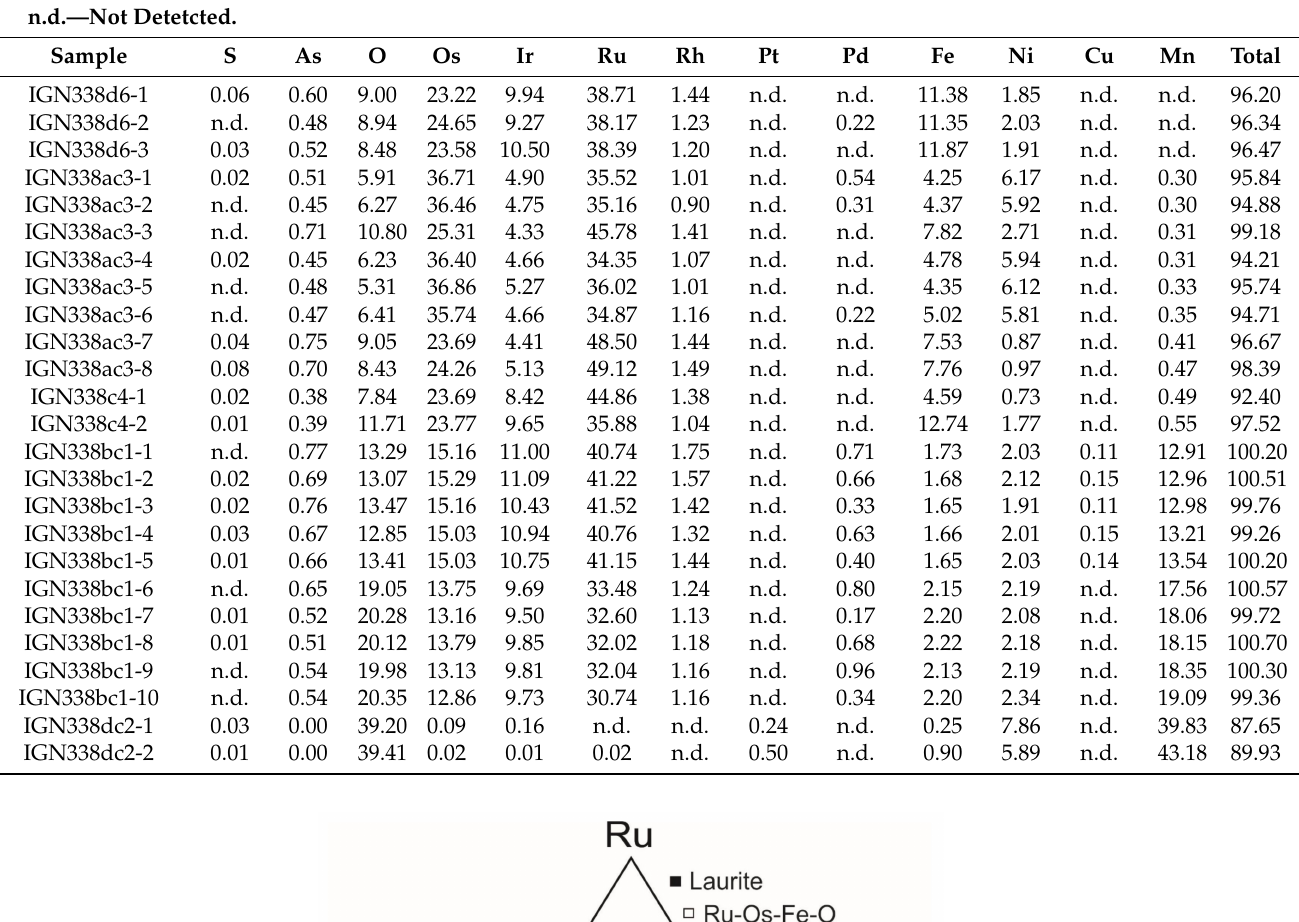
Table 6. Electron microprobe analyses (wt%) of PGE-bearing oxygenated compounds from high-Al chromitite of Sebuku Island.